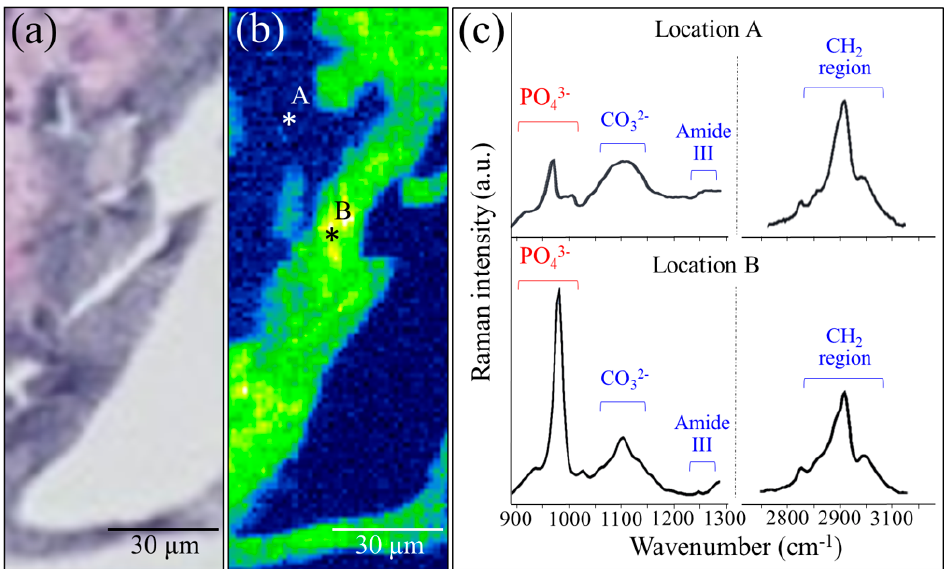
Figure 5. Enlarged view ( a ) and related Raman map ( b ) from a region in Figure 4c; low-and Figure 5 high-frequency Raman spectra collected at collagen- and apatite-rich locations (Locations A and B, respectively) are given in ( c ) (see labels in the